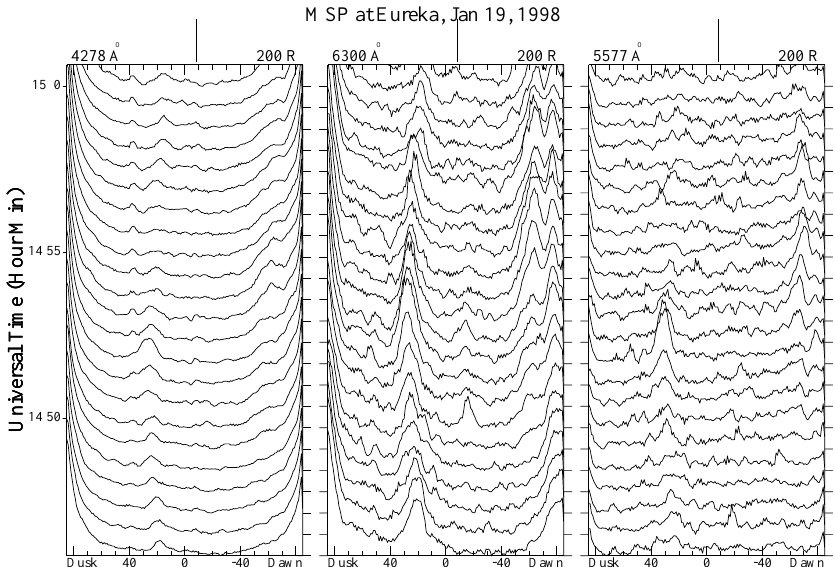
Fig. 6. Plots of Eureka MSP scans showing auroral intensities of 428 nm, 630.0 nm and 557.7 nm emissions along the dusk-dawn meridian over Eureka from 1445 to 1500 UT on January 19, 1998. The bars above each graph correspond to